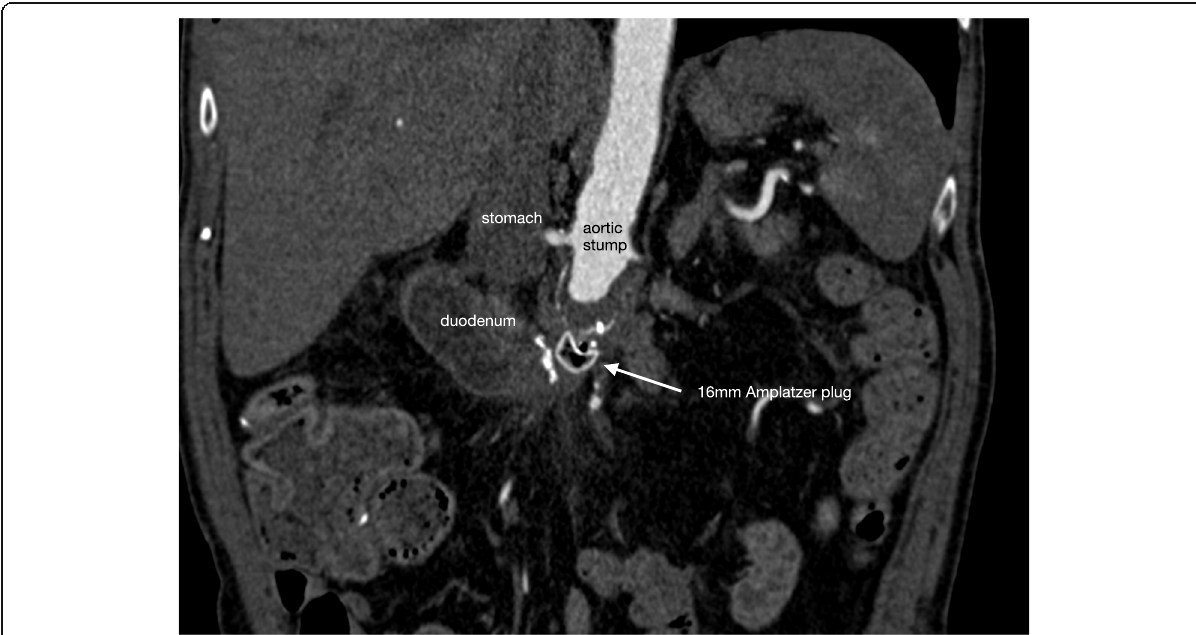
Fig. 3 CTA abdomen with the Amplatzer® plug in situ after 3 months. CTA after 3 months showed thrombosis of the aortic stump with the Amplatzer® Vascular Plug in